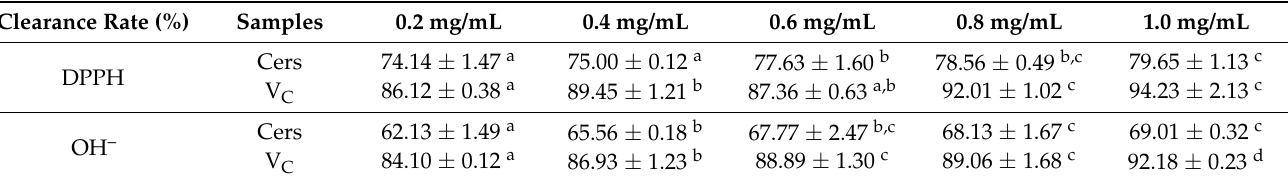
Table 5. Antioxidant activity of purified